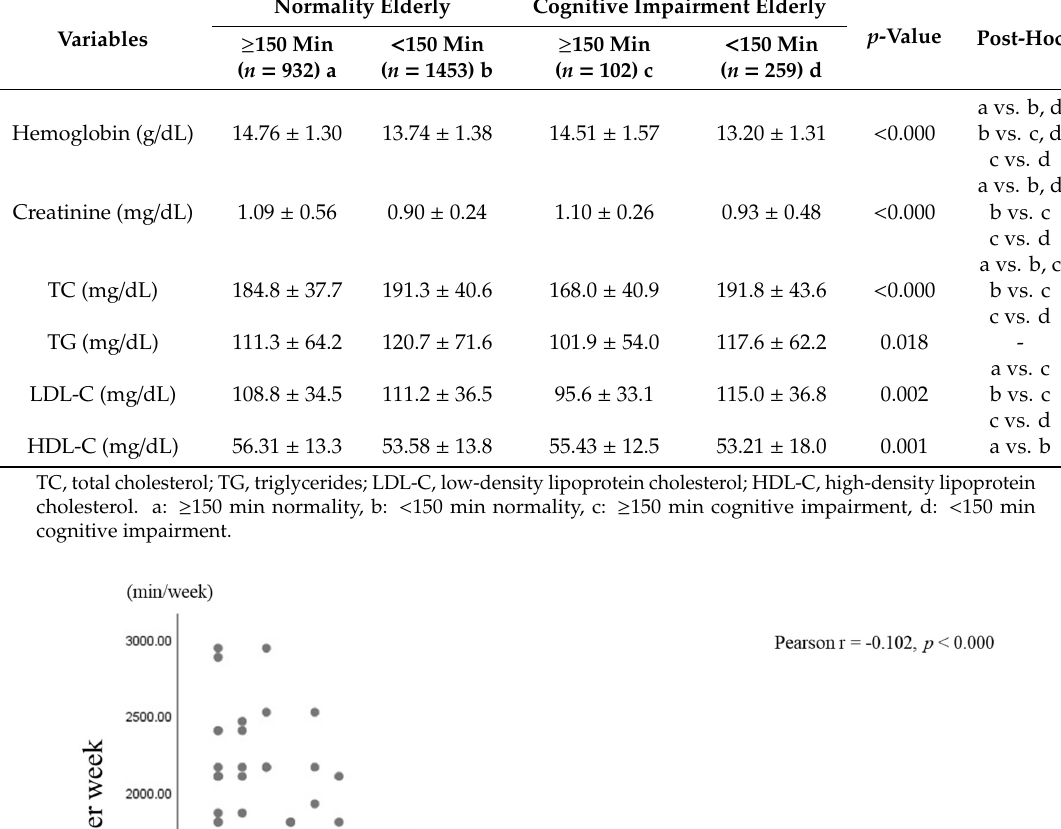
Table 3. Blood variables for each group.